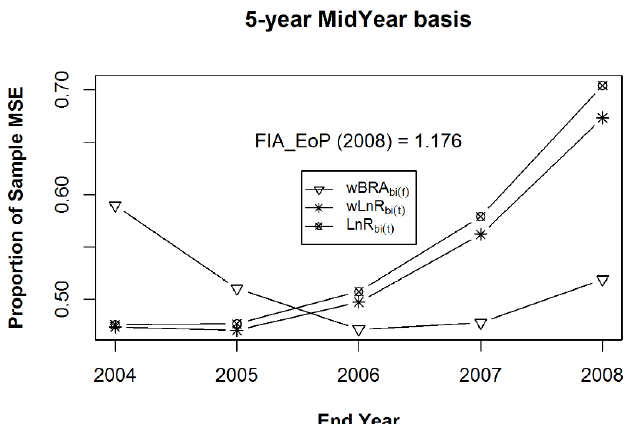
Figure 11. The mean bias ( a ) and the mean of Mean Squared Errors (( b ), expressed as a proportion of the MSE of the sample mean), relative to Estimand 1, for the bias ‐ adjusted EoP estimators (for years 2004–2008), using the strong prior sample, after 100 iterations of samples of size 1000 within the 125 populations of a composite sample of sample observation lengths of five, six, seven, eight, and nine years, in equal proportions.